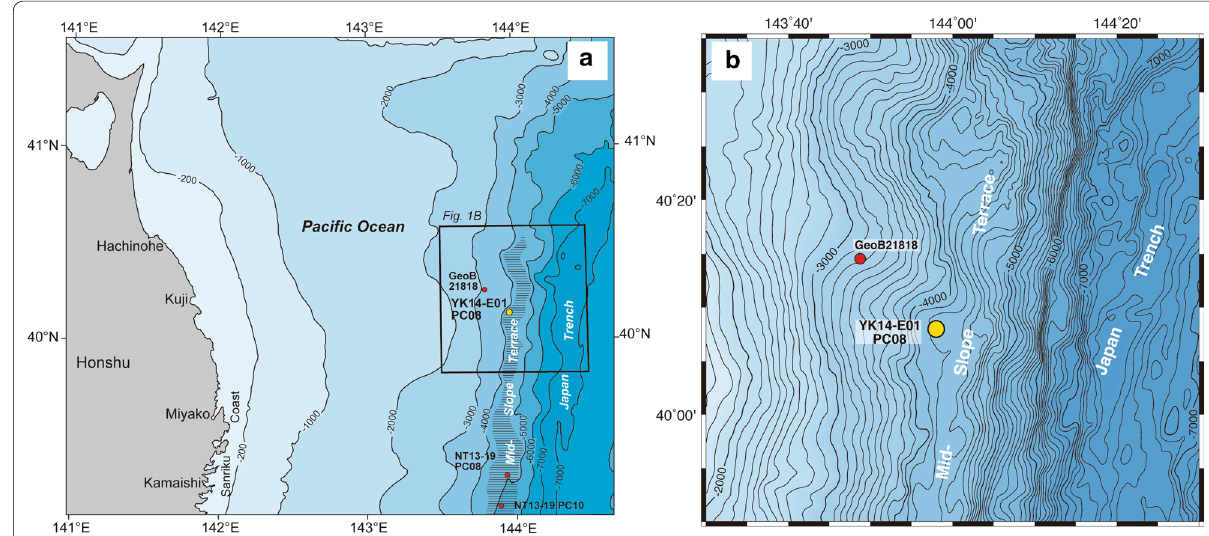
Fig. 1 a Bathymetry and location of the studied coring site (YK14-E01 PC08). Hatched area in a indicates the area of mid-slope terrace. Three coring sites (NT13-19 PC08, PC10 and GeoB21818) are shown. b Detailed bathymetry around the studied coring site